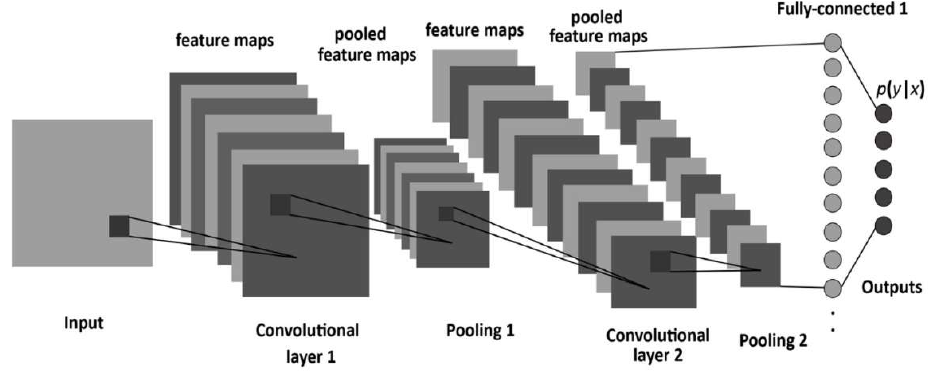
Figure 6. General configuration of a convolutional neural network (CNN).